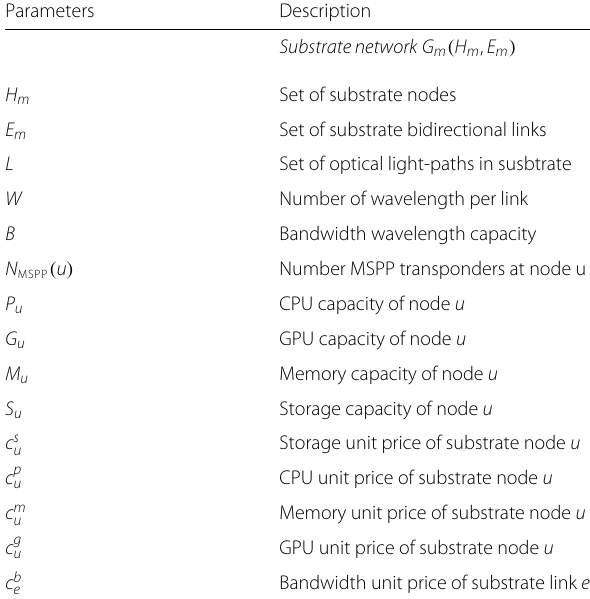
Table 1 Notation of MEC-DCs